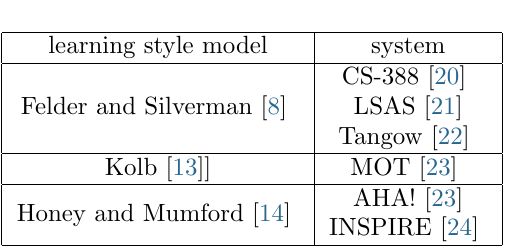
Table 1. Adaptive systems